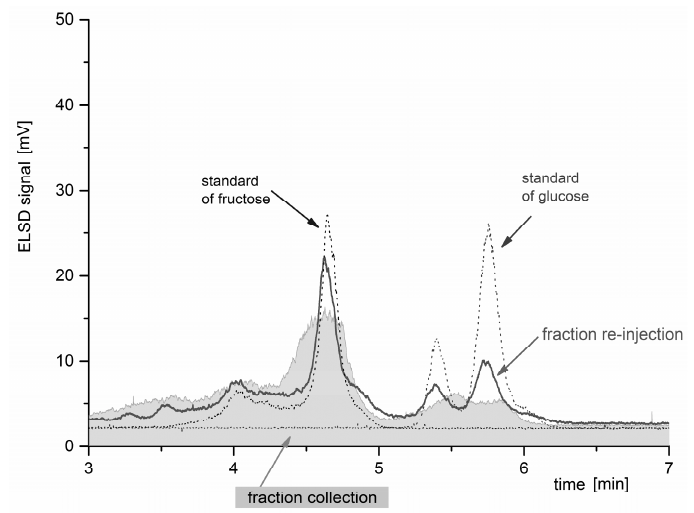
Figure 7. The splitter application to a real sample. The grey solid-filled chromatogram represents an extract of inner gel of P. magnifica used for fraction collection (injection volume was 50 µL, fractions were collected within 4–6 min). The fraction collected was evaporated to dryness under nitrogen, dissolved into 200 µL of water and then re-injected. The dotted traces show the chromatograms of the standards of fructose and glucose, respectively (each with a concentration of c = 2 mg/mL and an injection volume of 5 µL). Other experimental conditions: the temperature was 25 °C, the mobile phase was 90% acetonitrile/10% water, and the flow rate was 2 mL/min.